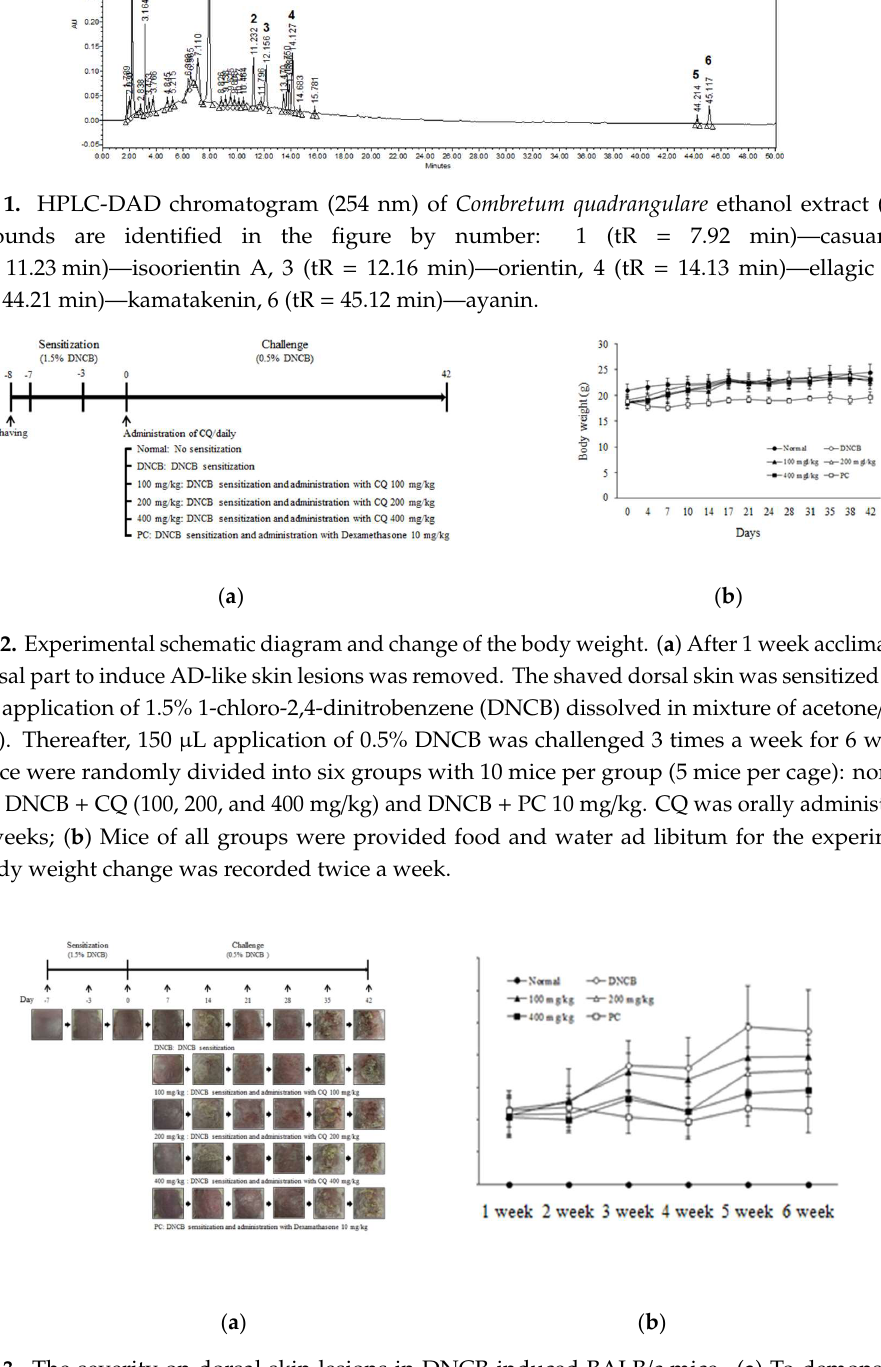
Molecules 2020 , 25 , x 3 of 16 barrier function parameters including pH, hydration, and transepidermal water loss (TEWL) were